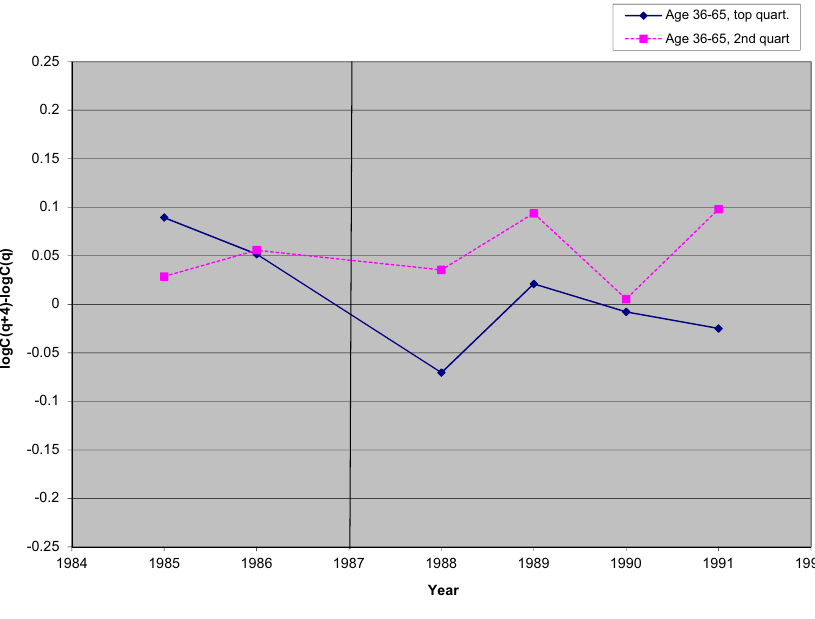
Fig. 1 Expenditure growth relative to 20–35, 1985–1991